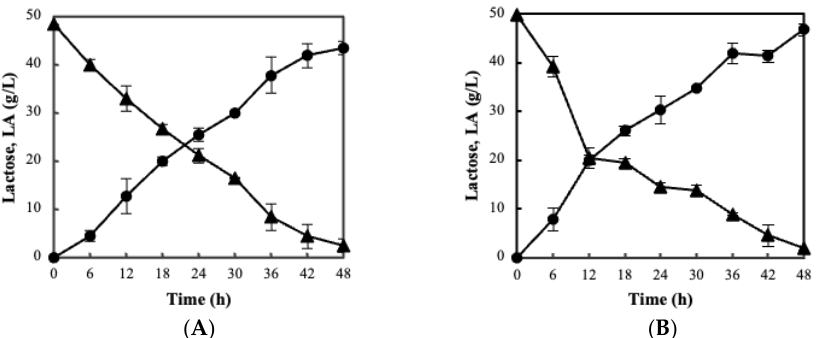
Figure 2. Kinetics of lactose ( ▲ ) and (●) lactic acid (LA) during CWP fermentation by BC-immobilized strain L. pentosus B329 ( Α ) and L. plantarum 820 ( Β ) at 37 °C.